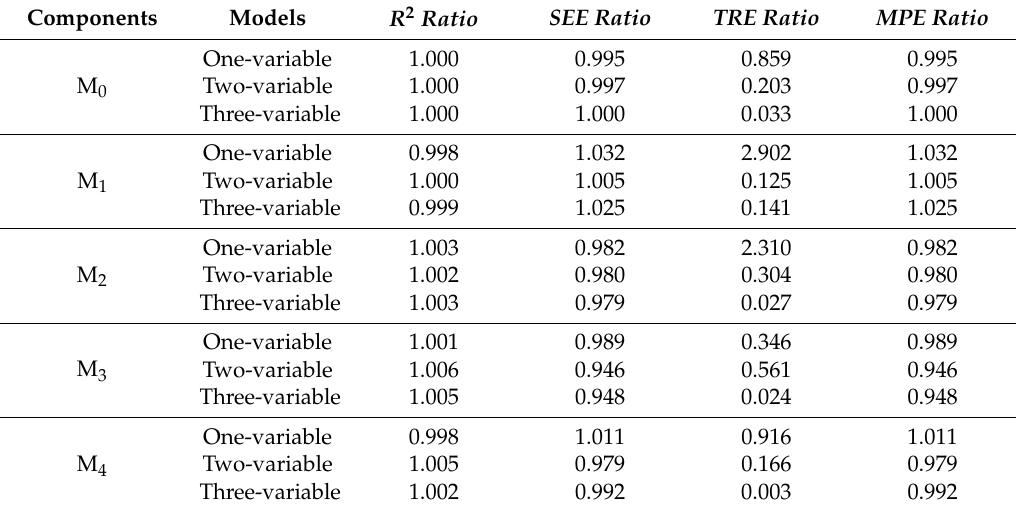
Table 7. The R 2 , SEE , TRE and MPE ratios for comparing prediction accuracy of the system of additive biomass equations and the independent biomass